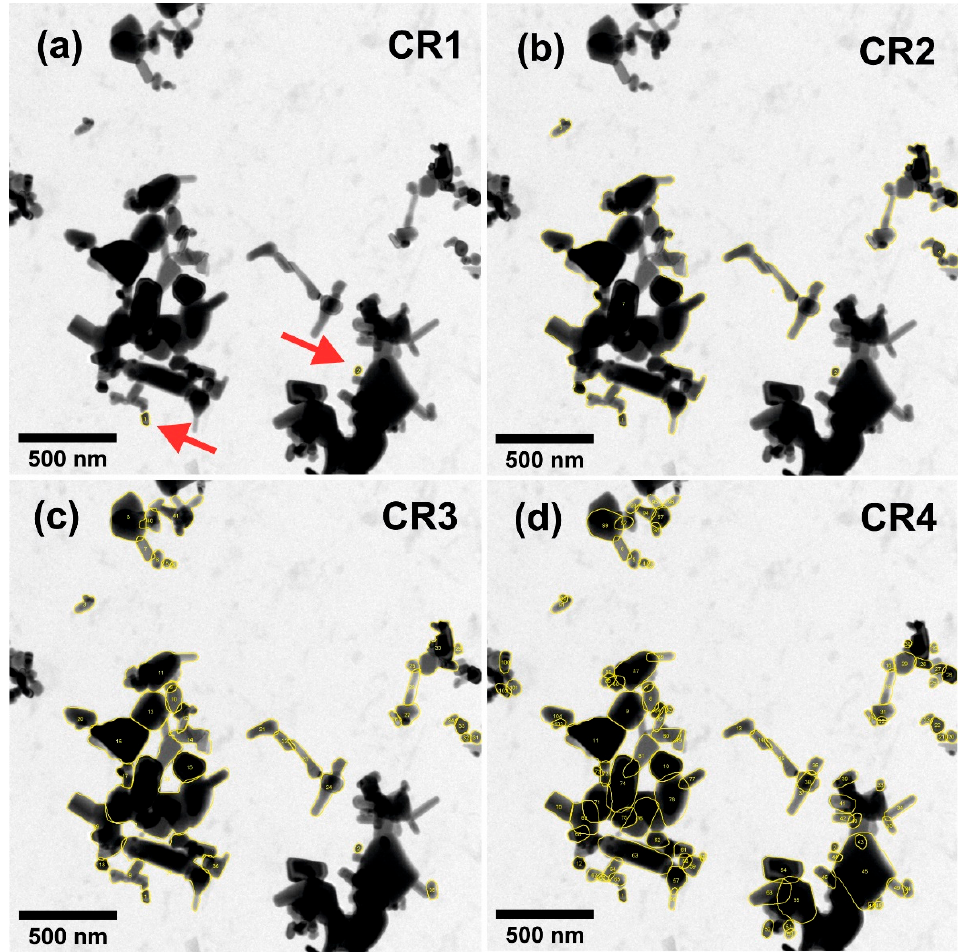
Figure 6. TEM image of overlapping zinc oxide particles with the particles marked according to the applied counting rule ( a ) CR1: 2 particles (pointed at by the red arrows), ( b ) CR2: 7 particles, ( c ) CR3: 41 particles, and ( d ) CR4: 104 particles. Counted particles have been given a yellow border. See Figures S1–S3 for the corresponding particle size distributions.